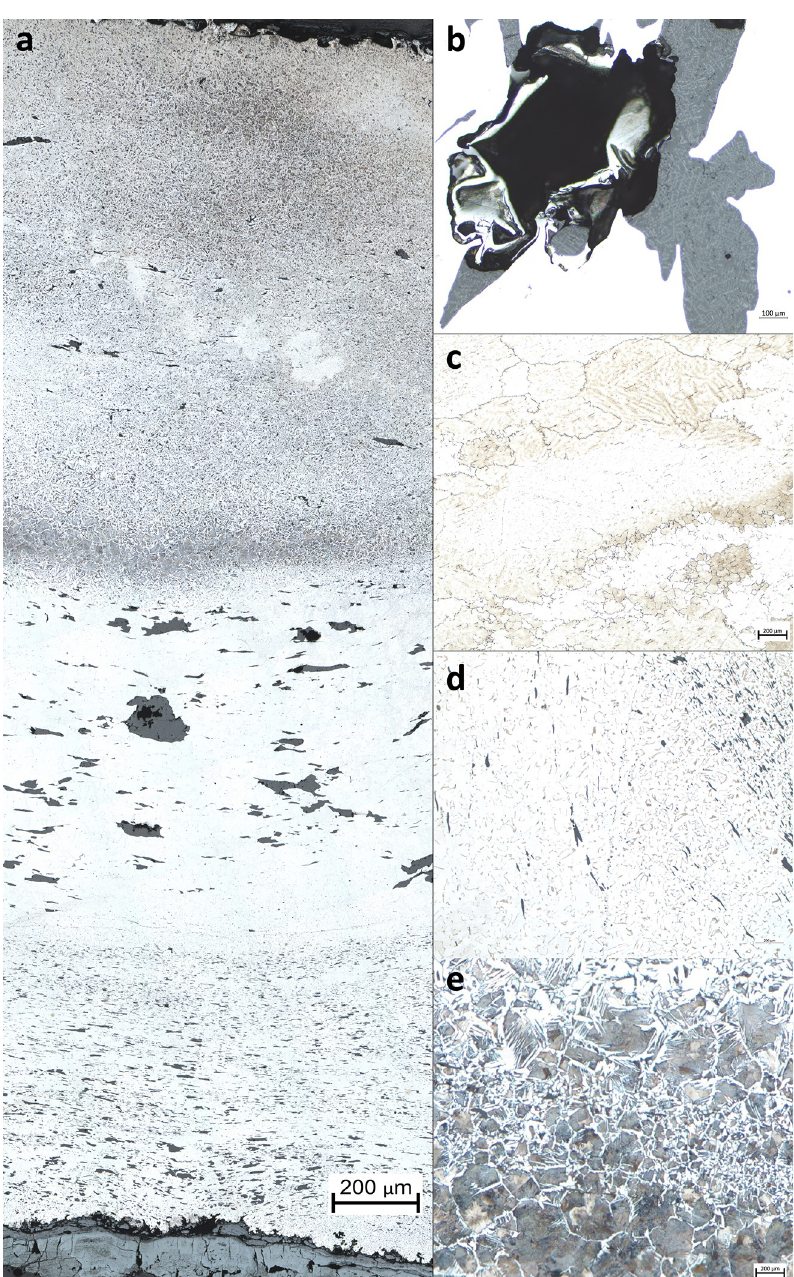
Fig 10. Metallographic features after Nital etching. a. Micrograph of NS8-L showing the welding of ferrous alloys of different qualities (from bottom to top, ferrite with small SI, ferrite with big SI, carburized ferrite-pearlite). b. Slag inclusion and porosity (NS106-T1). C. Ghost structure and different ferrite grain size (NS8-L), d. Slightly carburized zone with Widmansta¨tten ferrite and small SI (NS106T1) e. Carburized zone with Pearlite and Widmansta¨tten ferrite